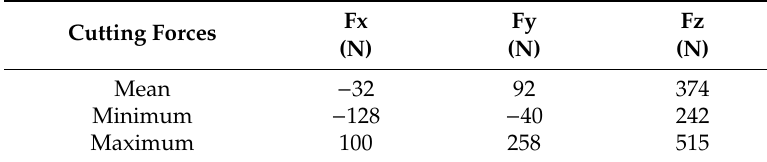
Table 6. The results of cutting forces for ap = 2.0 mm, f = 0.1 mm / rev; recorded during turning by tool with a new